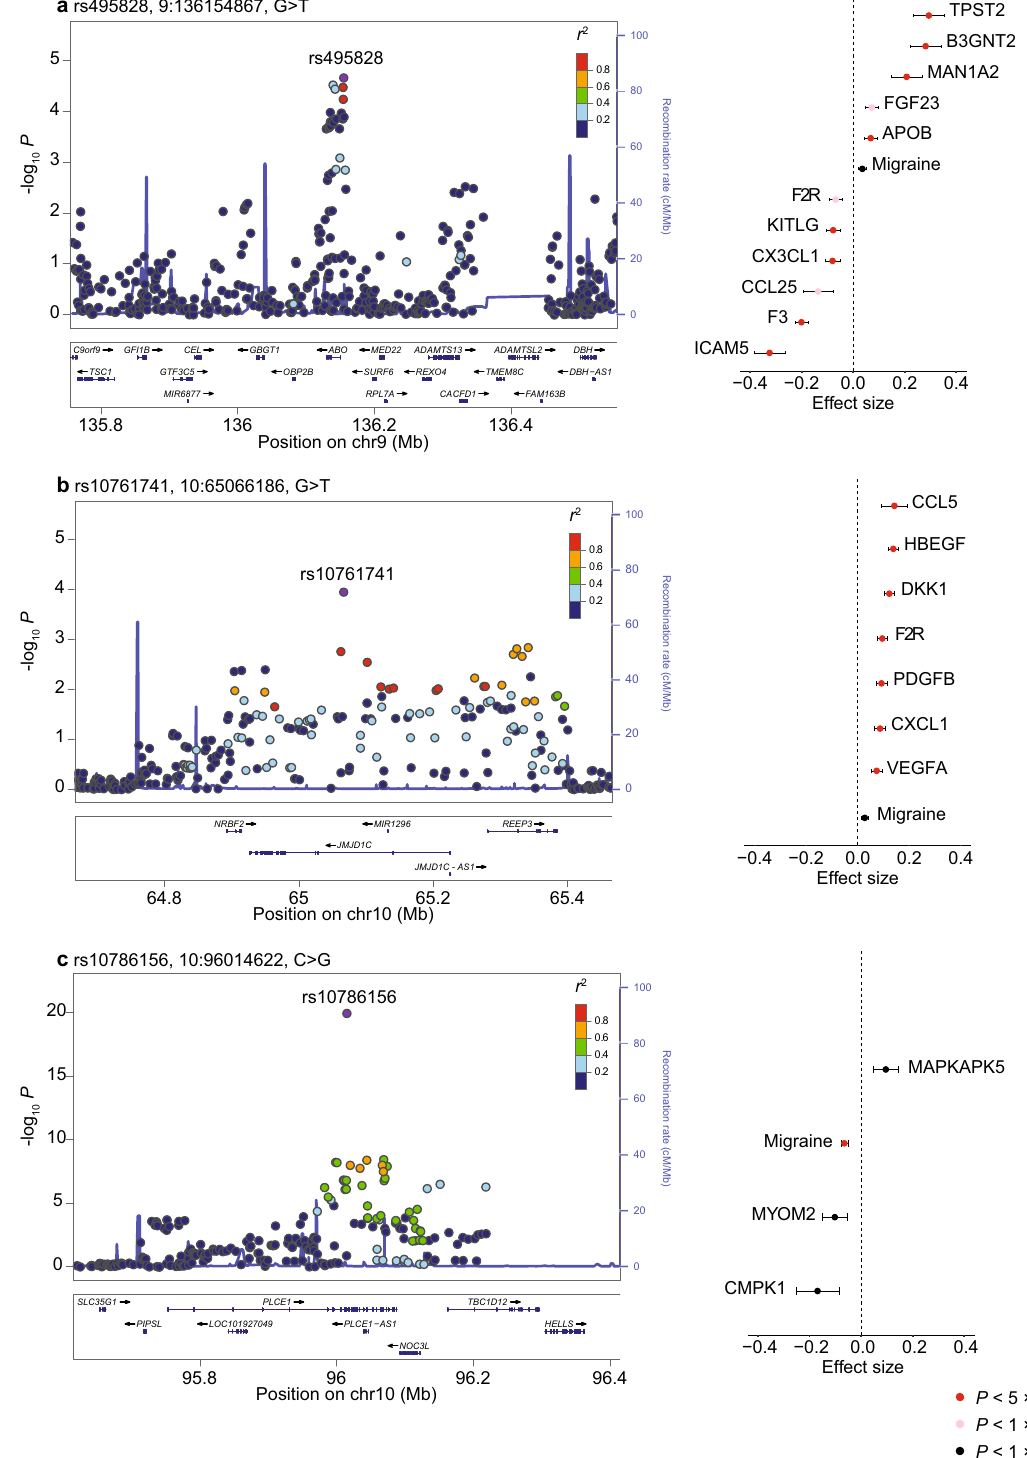
Fig. 3 Top three genomic loci in fl uencing migraine and 21 blood proteins via shared SNPs. LocusZoom plots of migraine GWAS for three pleiotropic loci that affect migraine and multiple proteins via shared SNPs are shown on left. Association effect sizes and their 95% con fi dence intervals of the shared SNP in each locus for migraine and identi fi ed blood proteins are shown on right. Unadjusted P -values for the associations from the migraine and protein GWASs are shown in red ( P < 5 × 10 – 8 ), pink ( P < 1 × 10 – 5 ) and black ( P < 1 × 10 – 3 ). a Chromosome 9: 135.3 – 137 Mb affects migraine and 11 blood proteins via rs495828 (position, 9:136154867; effect allele, T). b Chromosome 10: 63.3 – 65.8 Mb affects migraine and seven blood proteins via rs10761741